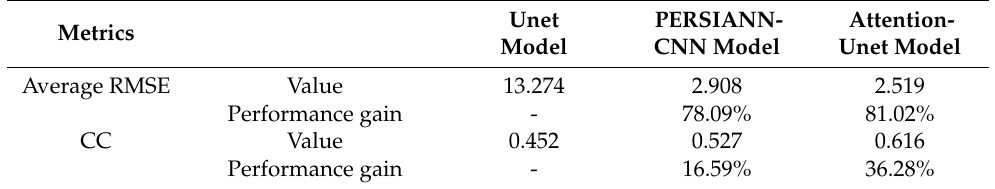
Table 11. Summary of precipitation estimation performance over extreme precipitation event. Metrics